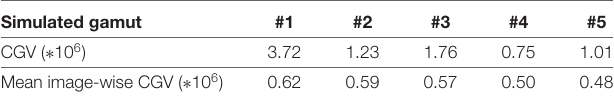
TABLE 2 | CGV for both gamut boundary and all images